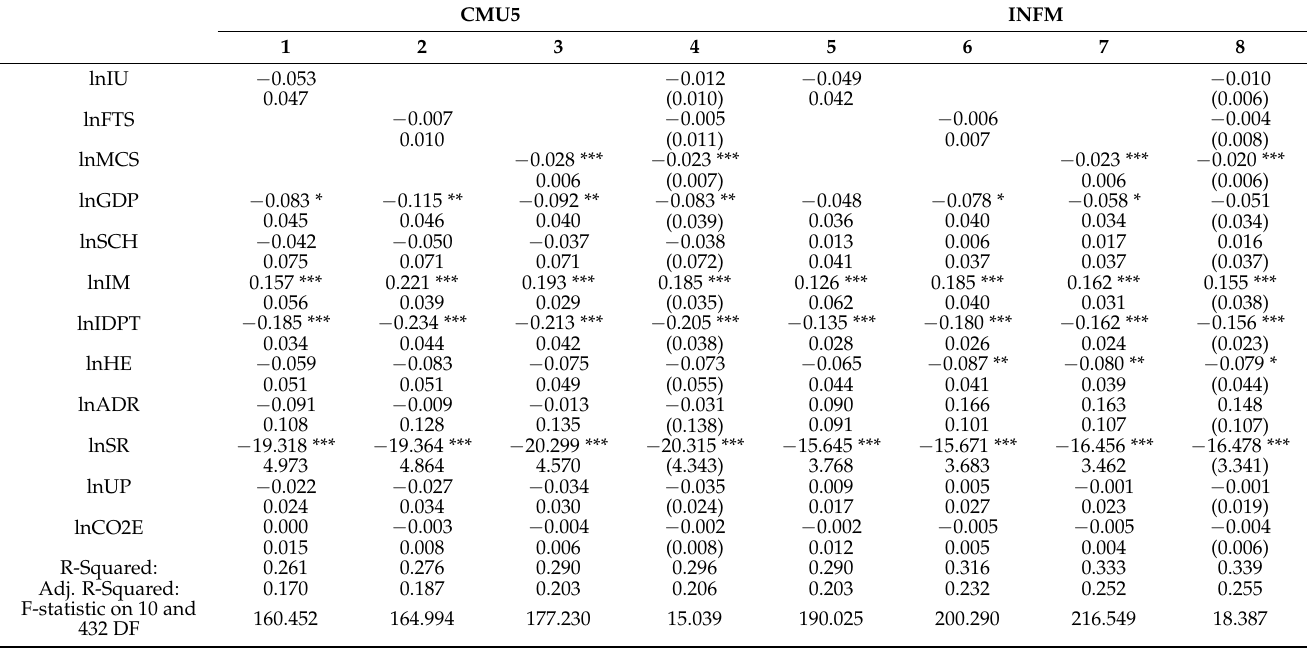
Table 4. Two-way FE using Driscoll–Kraay robust error estimation results for infant mortality and child mortality under